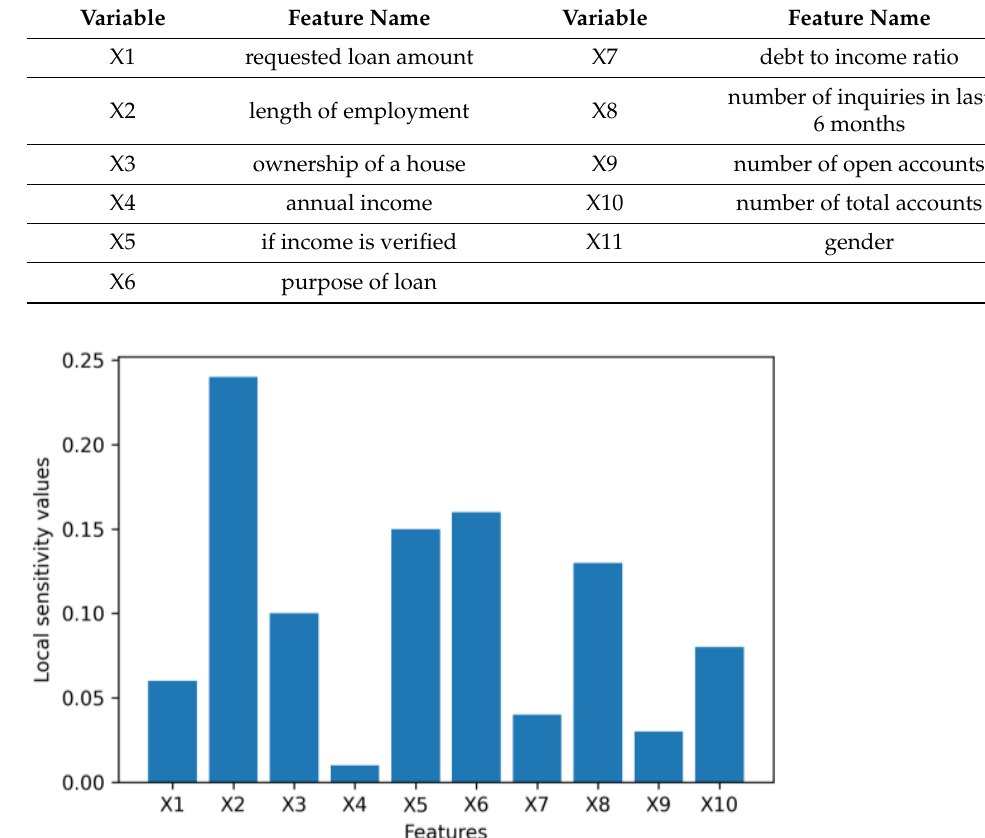
Figure 9. Local feature importance values for dataset 1.